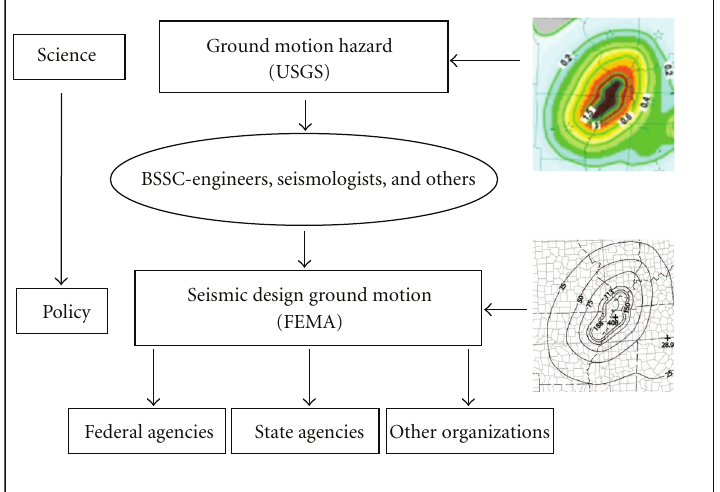
Figure 2: Development of the NEHRP recommended provisions: from seismic hazard map (science) to seismic design map (policy) in the United States.